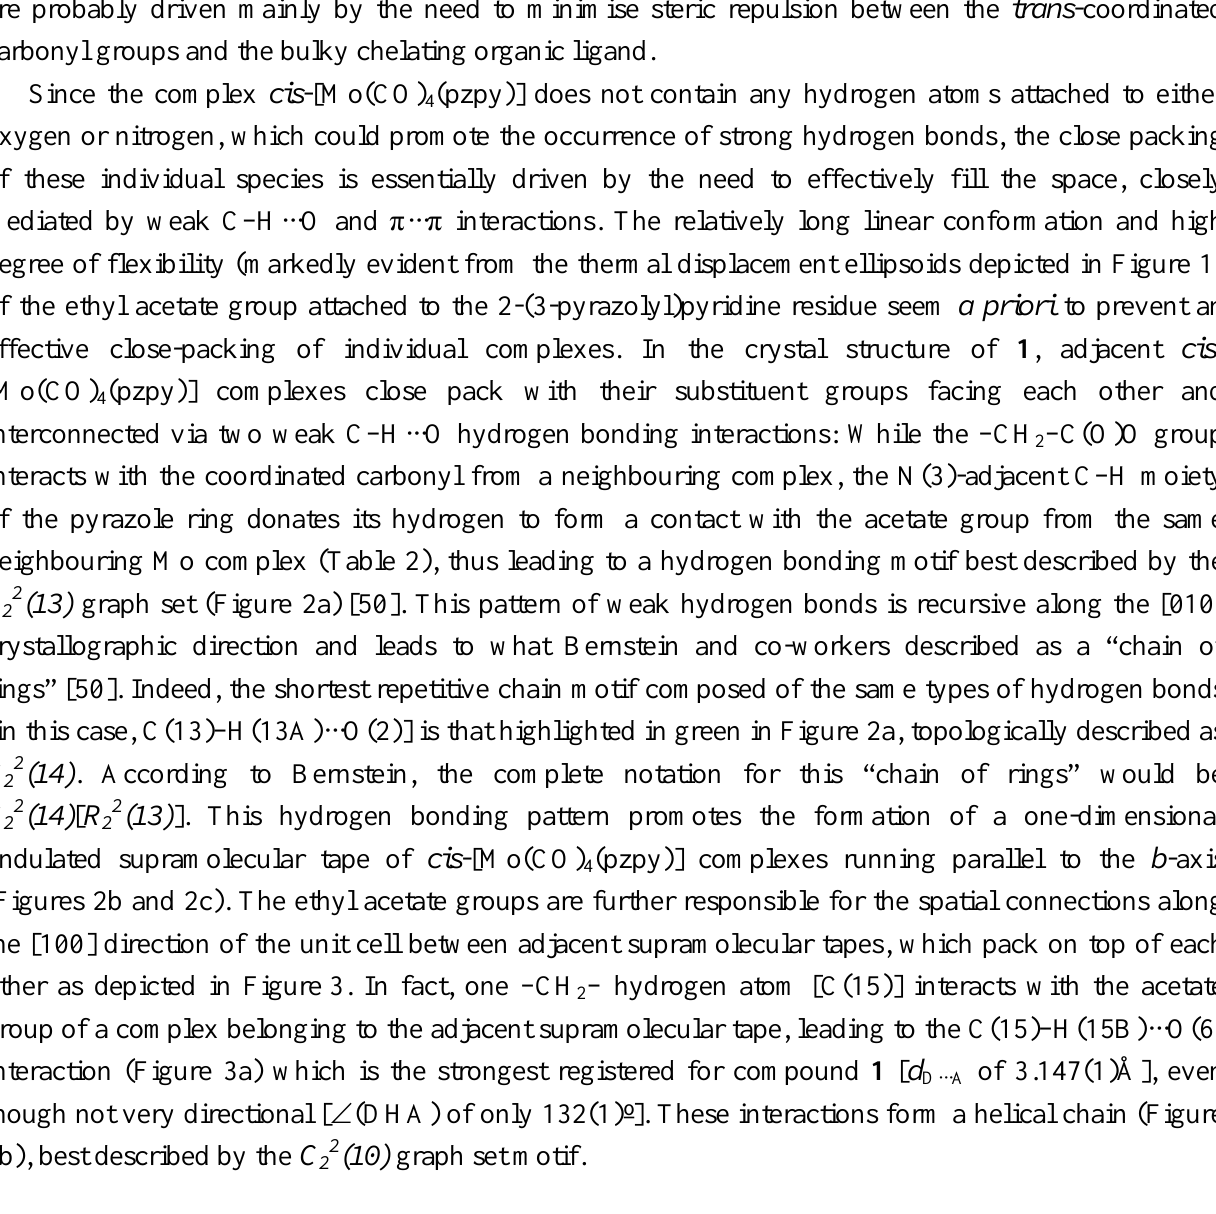
Hydrogen bonding geometry for the weak C–H···O contacts interconnecting adjacent cis -[Mo(CO) (pzpy)] complexes. 4